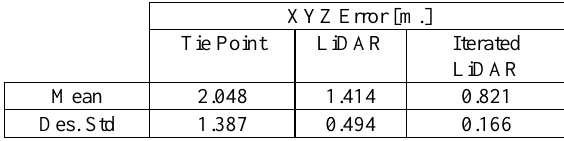
Table 7: 2001 Check Points error values